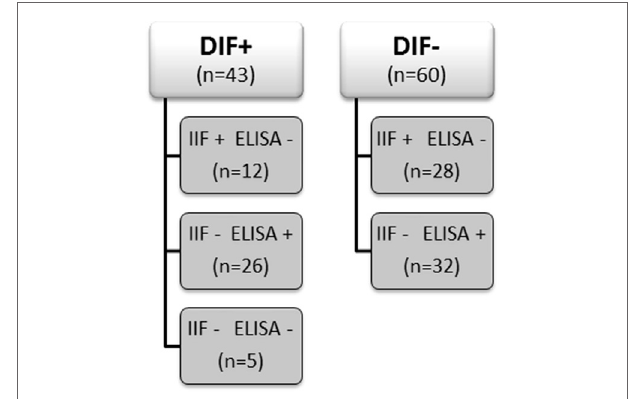
FigUre 1 | Groups’ characteristics and sampling